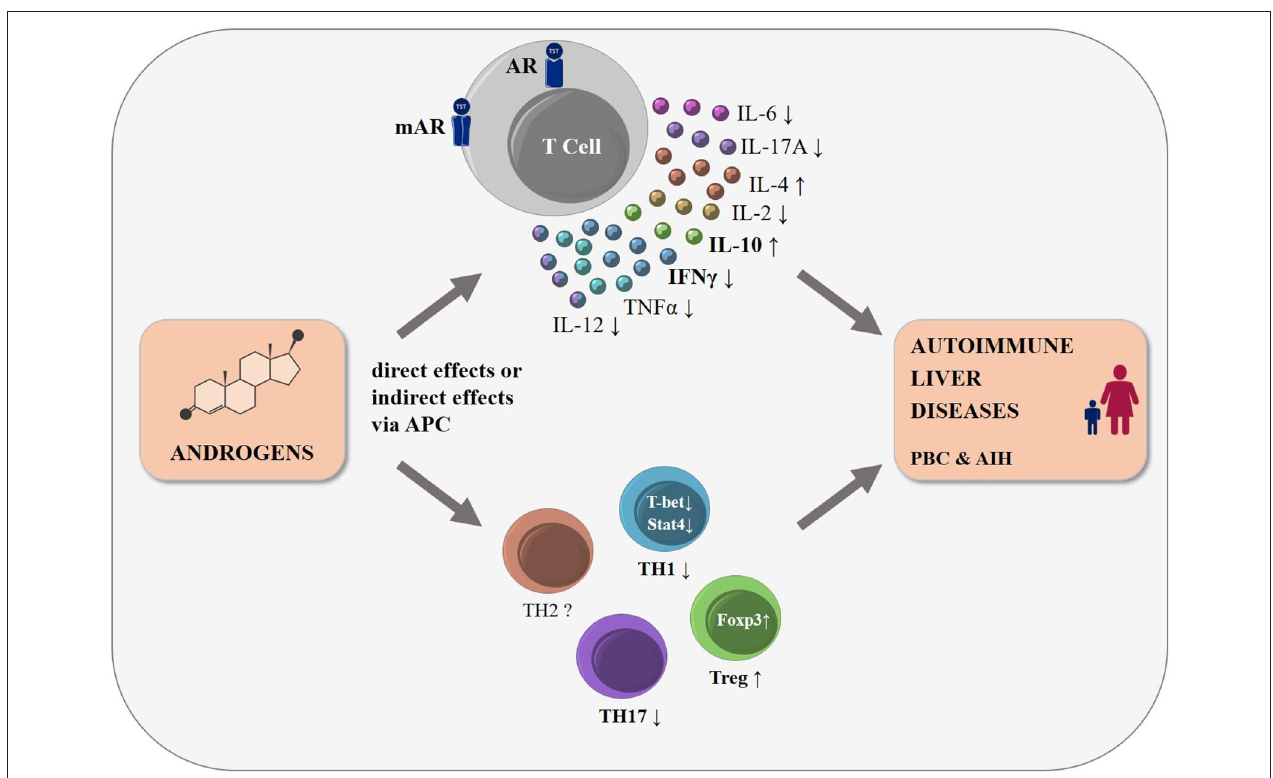
FIGURE 1 | The influence of androgens on T cell function and differentiation: schematic representation. Many autoimmune diseases, including the autoimmune liver diseases PBC and AIH, show a strong female predominance. Androgens modulate T cell development already in the thymus, mainly by altering thymic epithelial cell function (not shown). Human and mouse T cells express cytosolic (AR) and membrane bound androgen receptors (mAR). Androgens lead to changes in cytokine expression in T cells either directly or indirectly via antigen presenting cells, with a shift to a decreased pro-inflammatory cytokine expression, such as IFN γ and TNF, and an increased secretion of anti-inflammatory cytokines such as IL-10 and IL-4. Androgens were reported to reduce TH1-, TH17-, and to increase Treg-differentiation, while changes in other T cell subpopulations (e.g., TH2 cells) remain less clear. We postulate that these androgen-induced effects may influence the incidence and disease course of the T cell driven autoimmune liver diseases, PBC and